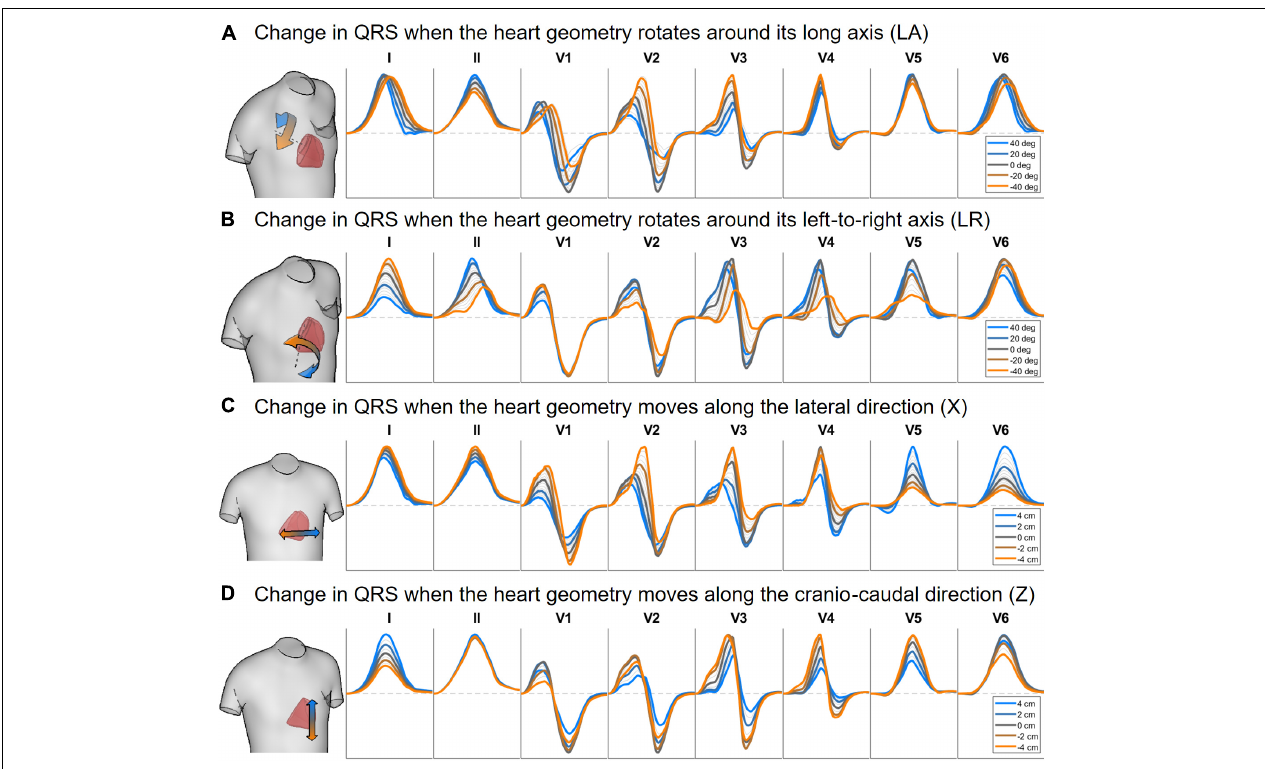
FIGURE 6 | Simulated QRS complex in leads I, II and V1 to V6 for different rotation angles around the long axis (A) and the left-to-right-ventricle direction (B) , and for different heart translations along the lateral (C) and cranio-caudal (D) directions. Gray lines correspond to intermediate results showing how the signals evolve from one colored state to another. The heart and torso geometries correspond to subject